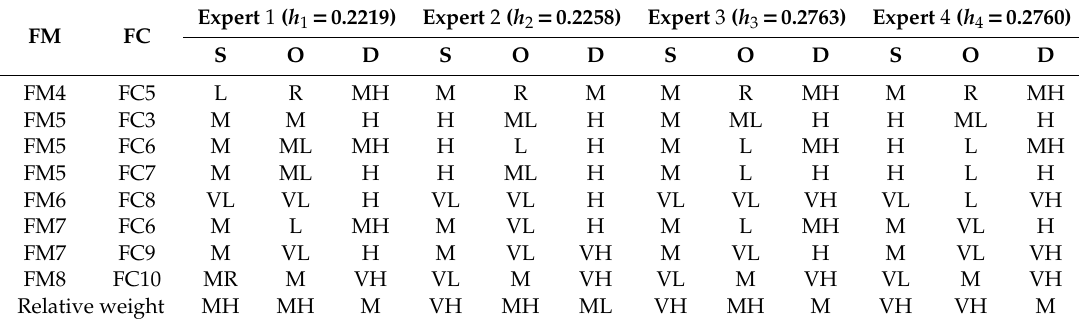
Table 7. Fuzzy evaluation of the risk factors and relative weights for a permanent magnet synchronous motor. Severity (S), occurrence (O), and detectability (D).